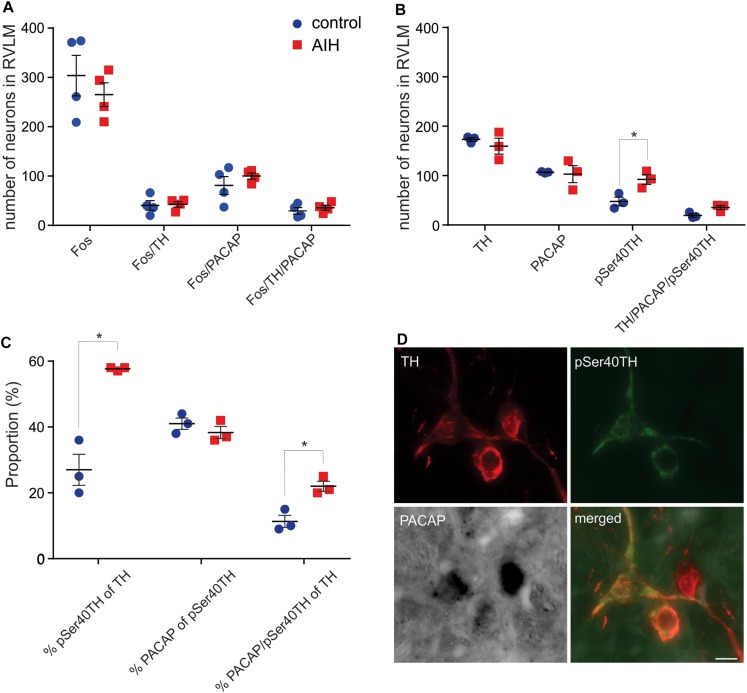
C1 neurons in rat RVLM are activated by AIH. (A) Mean ± SEM number of neurons in RVLM stained for Fos, TH and PACAP mRNA 60 min after control (n = 4) or AIH (n = 4). There are no differences in Fos staining, in any population, between the two treatment groups. (B) Neurons in RVLM (mean ± SEM) stained for pSer40TH, TH and PACAP mRNA 60 min after control (n = 3) or AIH (n = 3). Number of neurons expressing pSer40TH doubled in the AIH treated group compared to control. (C) The data from (B) is expressed as proportion of TH or pSer40TH populations. AIH caused a doubling in the proportion of TH neurons that also expressed pSer40TH (27 ± 5% vs. 58 ± 0.3%) and a doubling in the proportion of TH neurons that also contained pSer40TH and PACAP mRNA. (D) Micrographs with 3 neurons, from an AIH treated rat, stained for TH, pSer40TH and PACAP mRNA, and a merged image. All 3 TH neurons are positive for PACAP mRNA but only 2 are pSer40TH positive. RVLM – rostral ventrolateral medulla. Scale bar represents 10 μm. ∗P < 0.05.